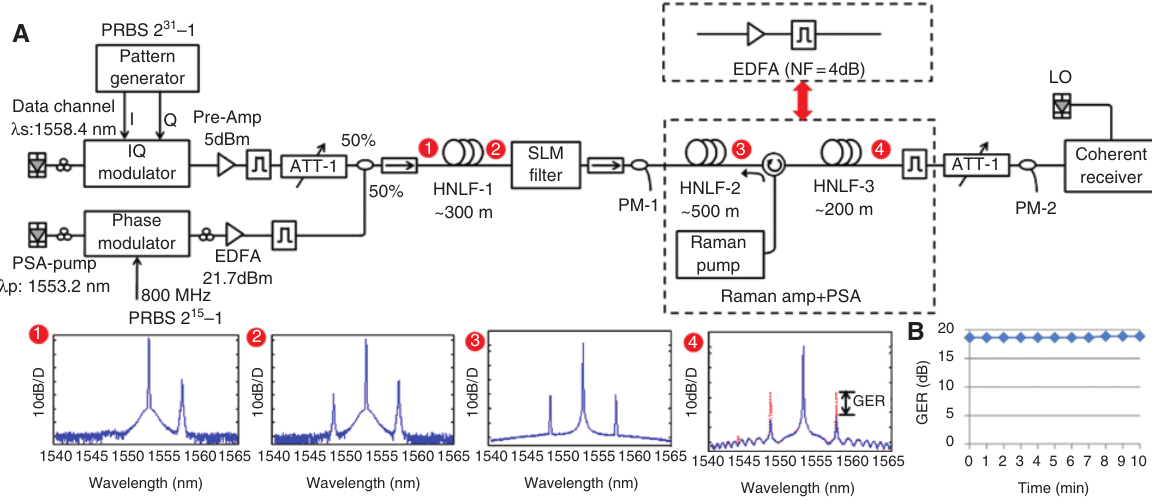
Figure 28: Raman-assisted PSA system